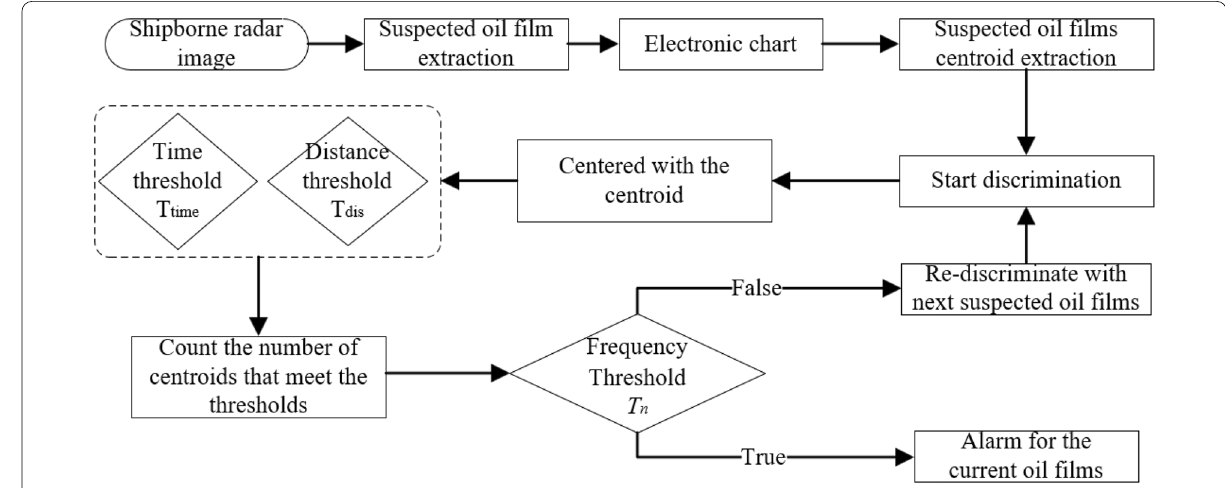
Fig. 4 Oil spill discrimination